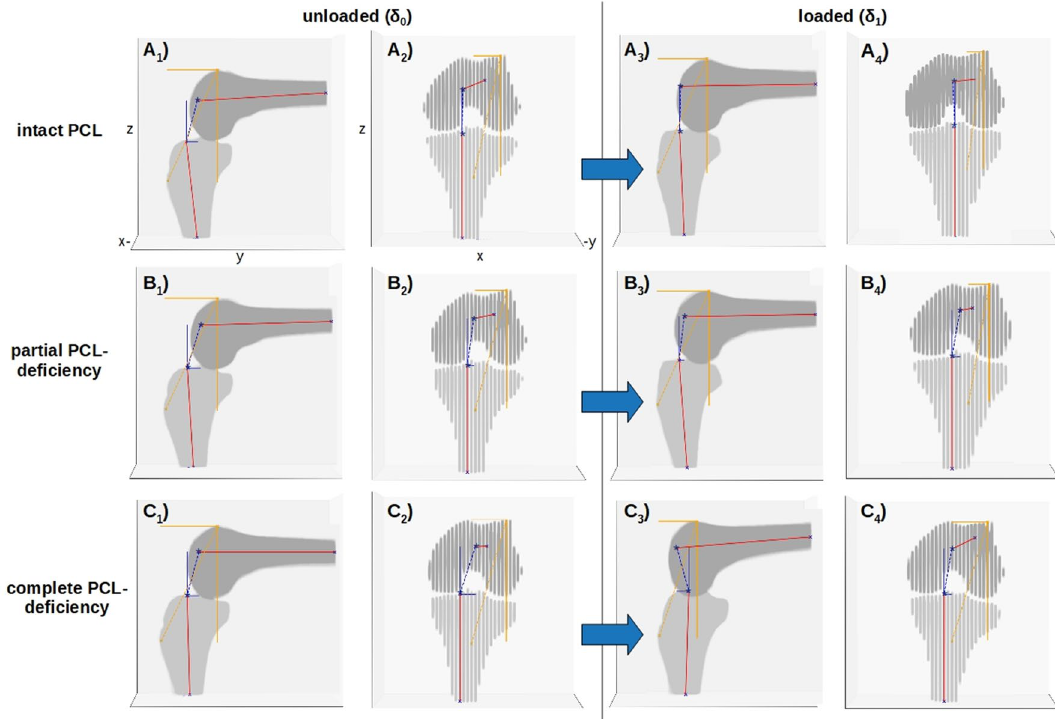
Figure 1. Multidimensional 3D Computed Vector Measures to Quantify Joint Laxity as a Function of PCL Injury and Loading. Displayed are the PCL-intact ( A ), partially ( B ), and completely ( C ) PCL-deficient conditions in the unloaded ( A 1–2 – C 1–2 ) and loaded ( A 3–4 – C 3–4 ) configurations of a representative left knee joint specimen. Manually segmented bone contours of the femur (dark grey) and tibia (light grey) are displayed in the yz- (sagittal, A 1 – C 1 , A 3 – C 3 ) and xz-dimensions (coronal, A 2 – C 2 , A 4 – C 4 ). While the amount of posterior translation of the tibia relative to the femur was limited in the PCL-intact ( A ) and partially PCL-deficient conditions ( B ), it was considerably larger in the presence of complete PCL injury ( C ). Blue block arrows indicate the direction of force during the MRI posterior drawer test . Please refer to Supplementary Fig. 1 and the main text for details on vectors, axes, fixpoints, and anatomic landmarks. Same knee joint specimen as in Fig. 2 and Supplementary Figs. 1 and